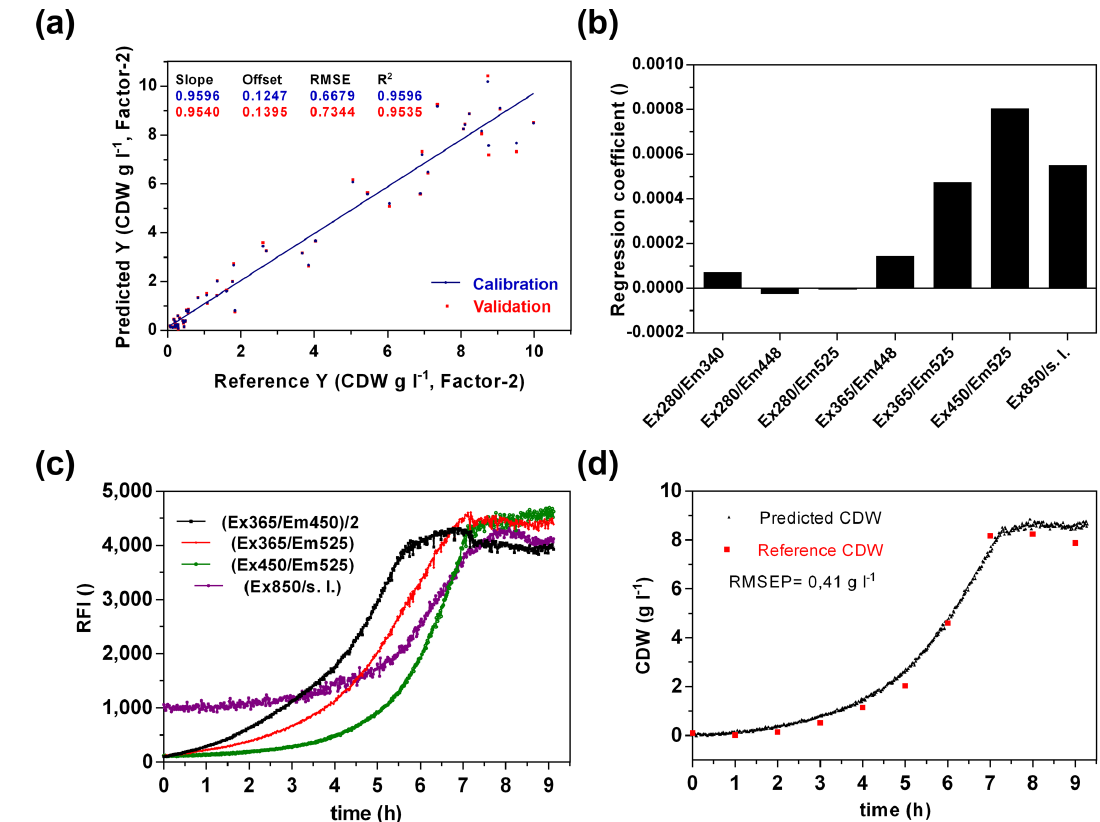
Figure 5. Biomass prediction of an E. coli K1 cultivation via a fluorescence sensor. (a) PLS regression model of CDW. (b) Regression coefficients of the PLS model. (c) Fluorescence data of the fermentation. (d) Predicted biomass and offline measured